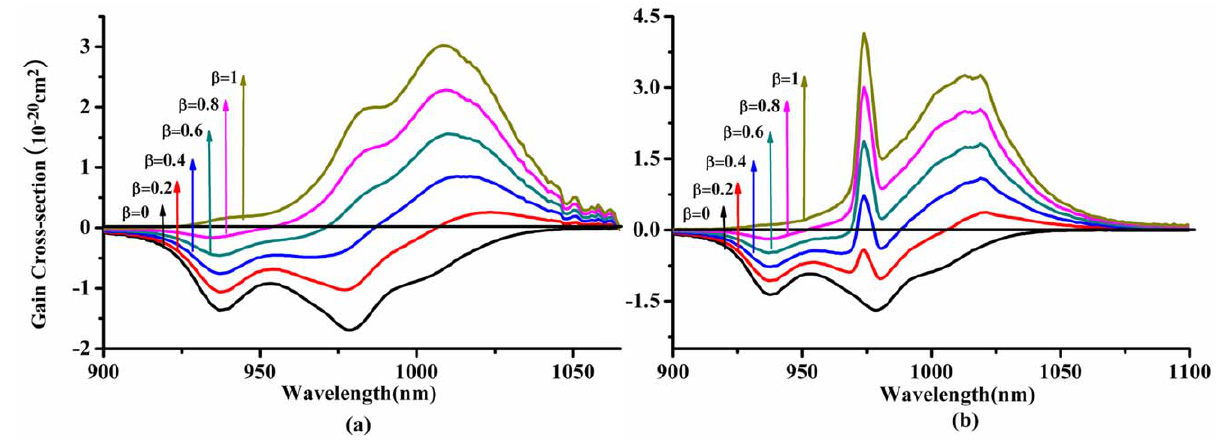
Figure 13. Gain profiles for the Y direction of Yb 3 + :KBaGd(MoO 4 ) 3 crystal obtained by two methods: (a) the RM method and (b) the F-L